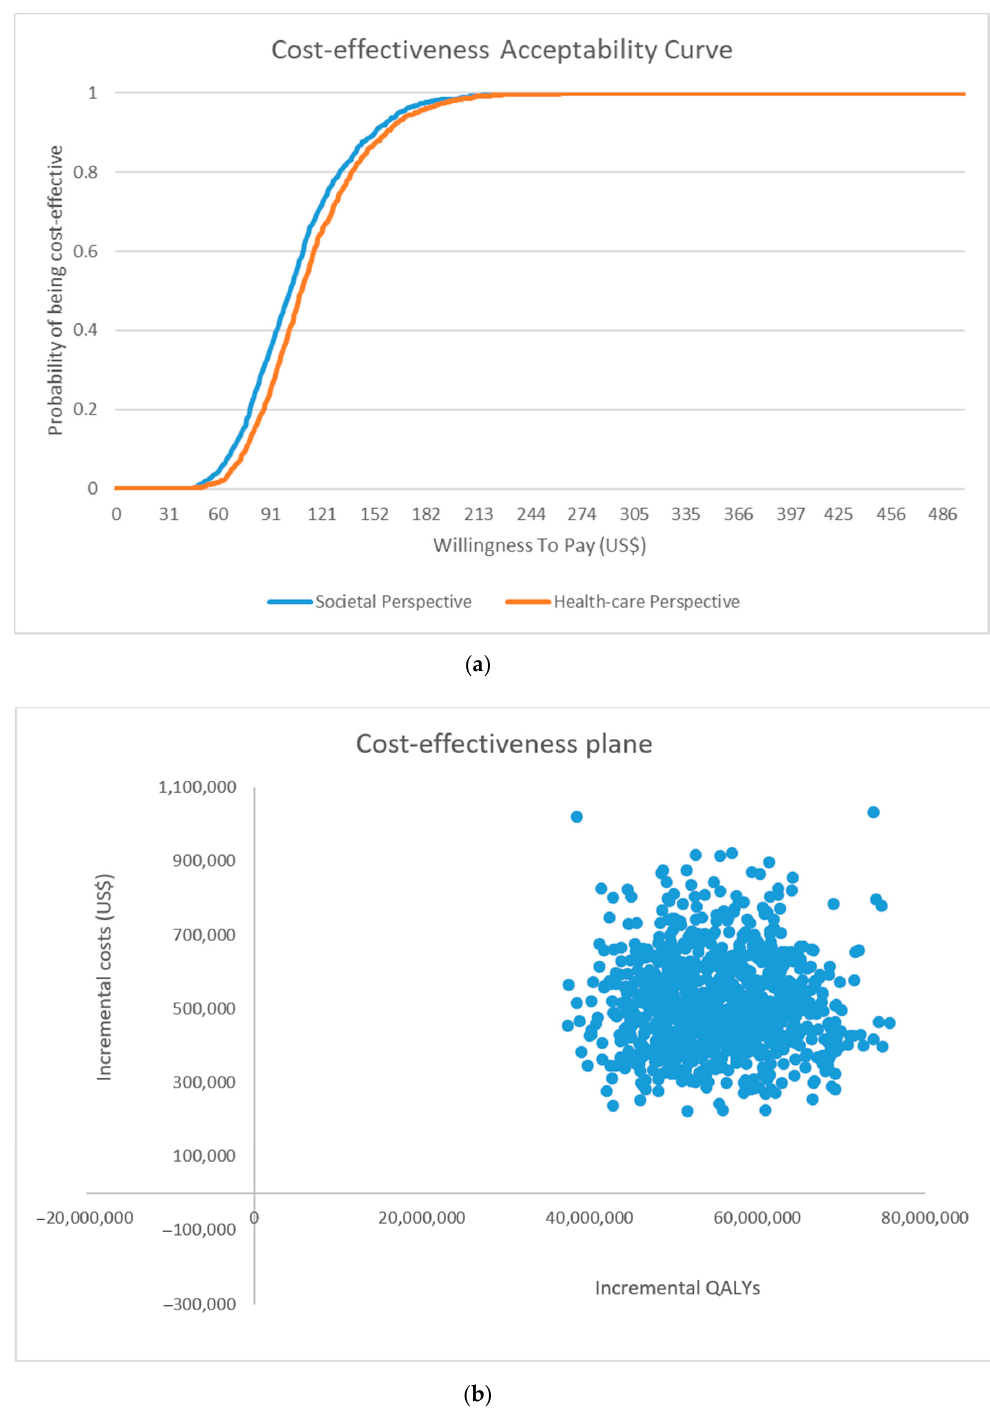
Figure 5. ( a ) Cost-effectiveness acceptability curves and ( b ) Cost-effectiveness plane of health-care perspective obtained from the probabilistic sensitivity analysis. QALYs = quality-adjusted life years